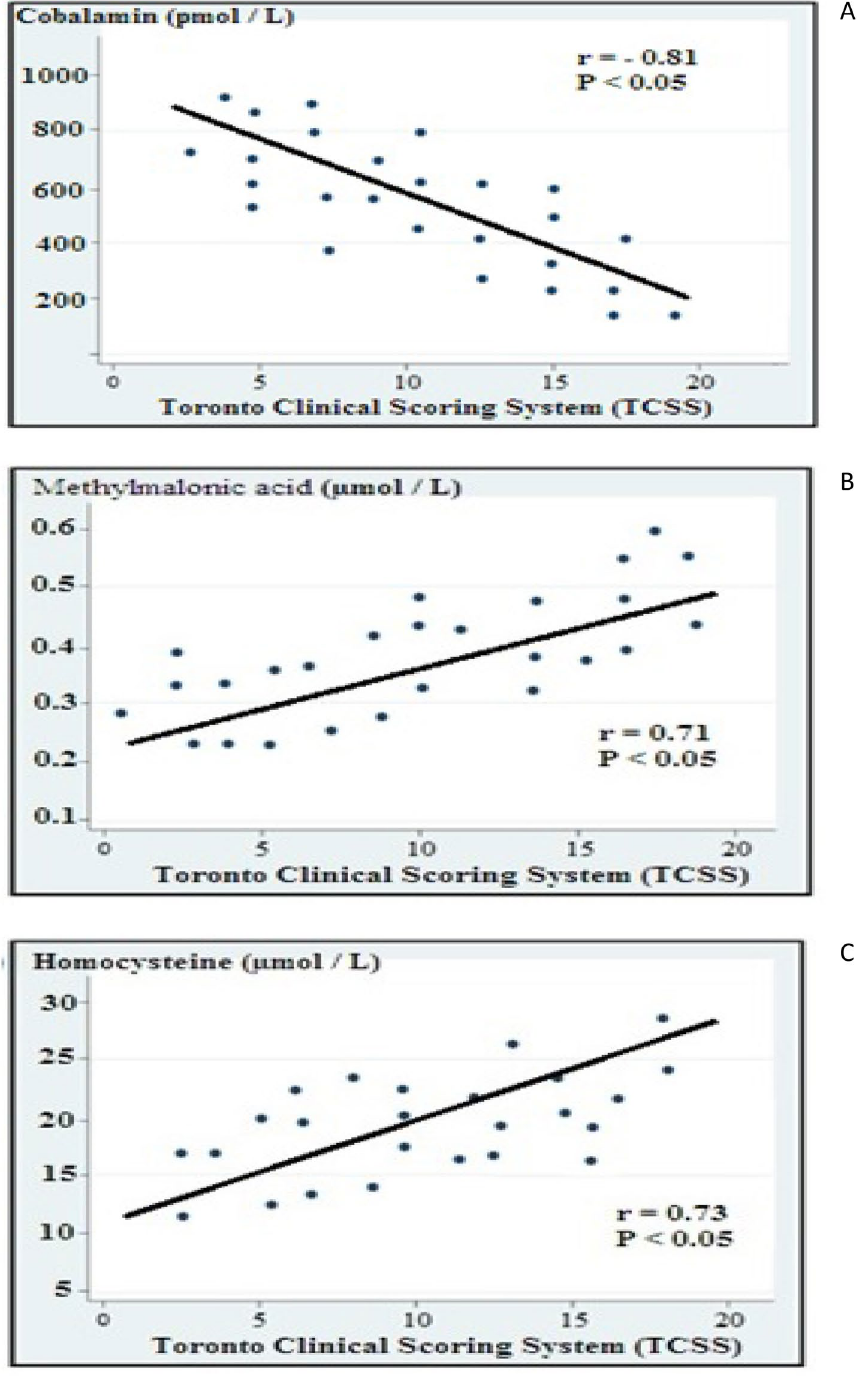
Figure 2. Correlation of the severity of DPN with ( A ) cobalamine, ( B ) methymalonic acid, and ( C )